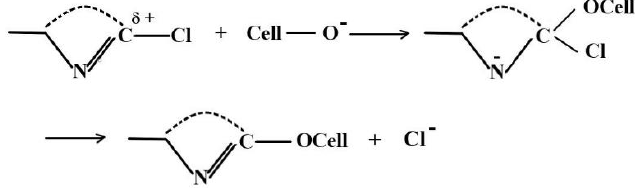
Figure 11. Schematic diagram of the reaction between cellulose and chloropyrimidine.